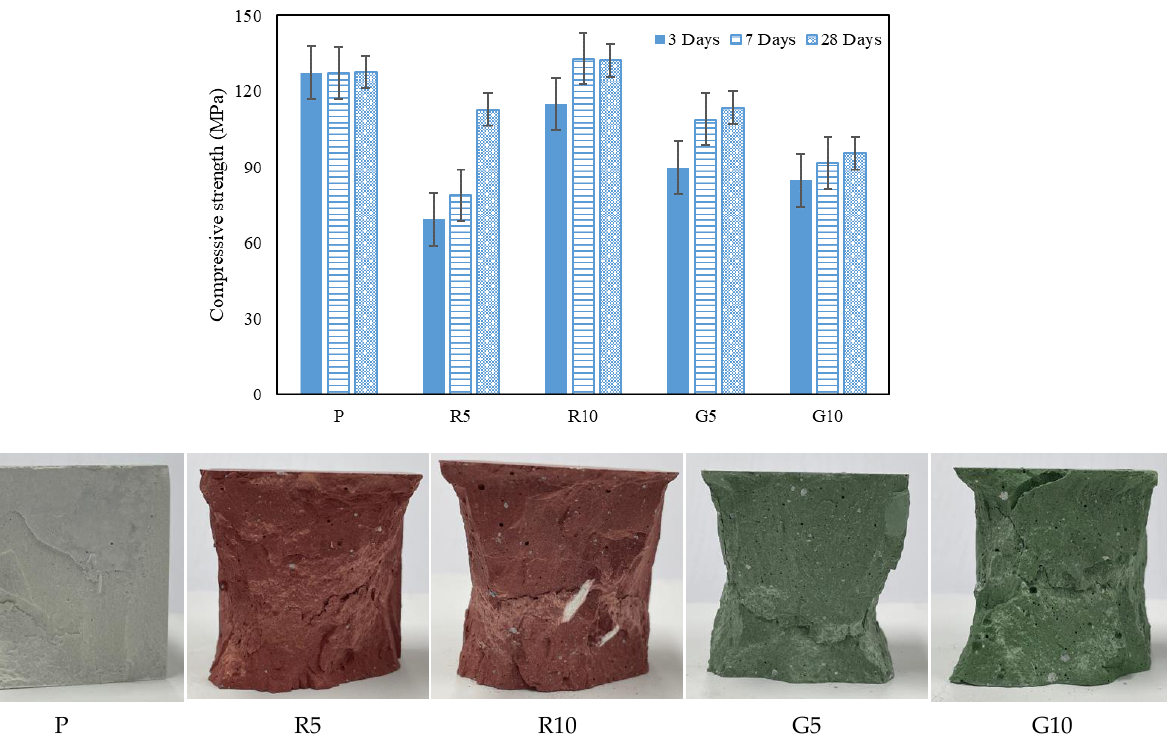
Figure 2. Compressive strength at each age and fracture images of specimens. The strengths at different ages are indicated in the bar diagram, and the error range is within the 95% confidence inter-